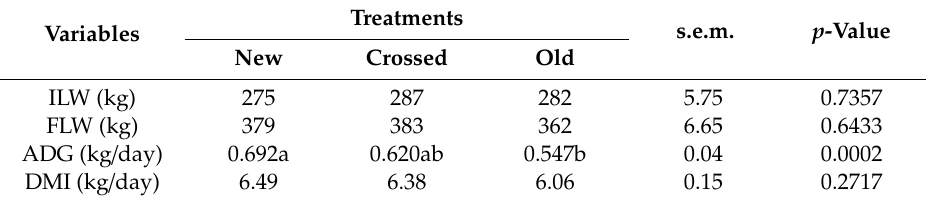
Table 3. Performance and e ffi ciency of Canchim steers from di ff erent lines reared on pasture. Variables